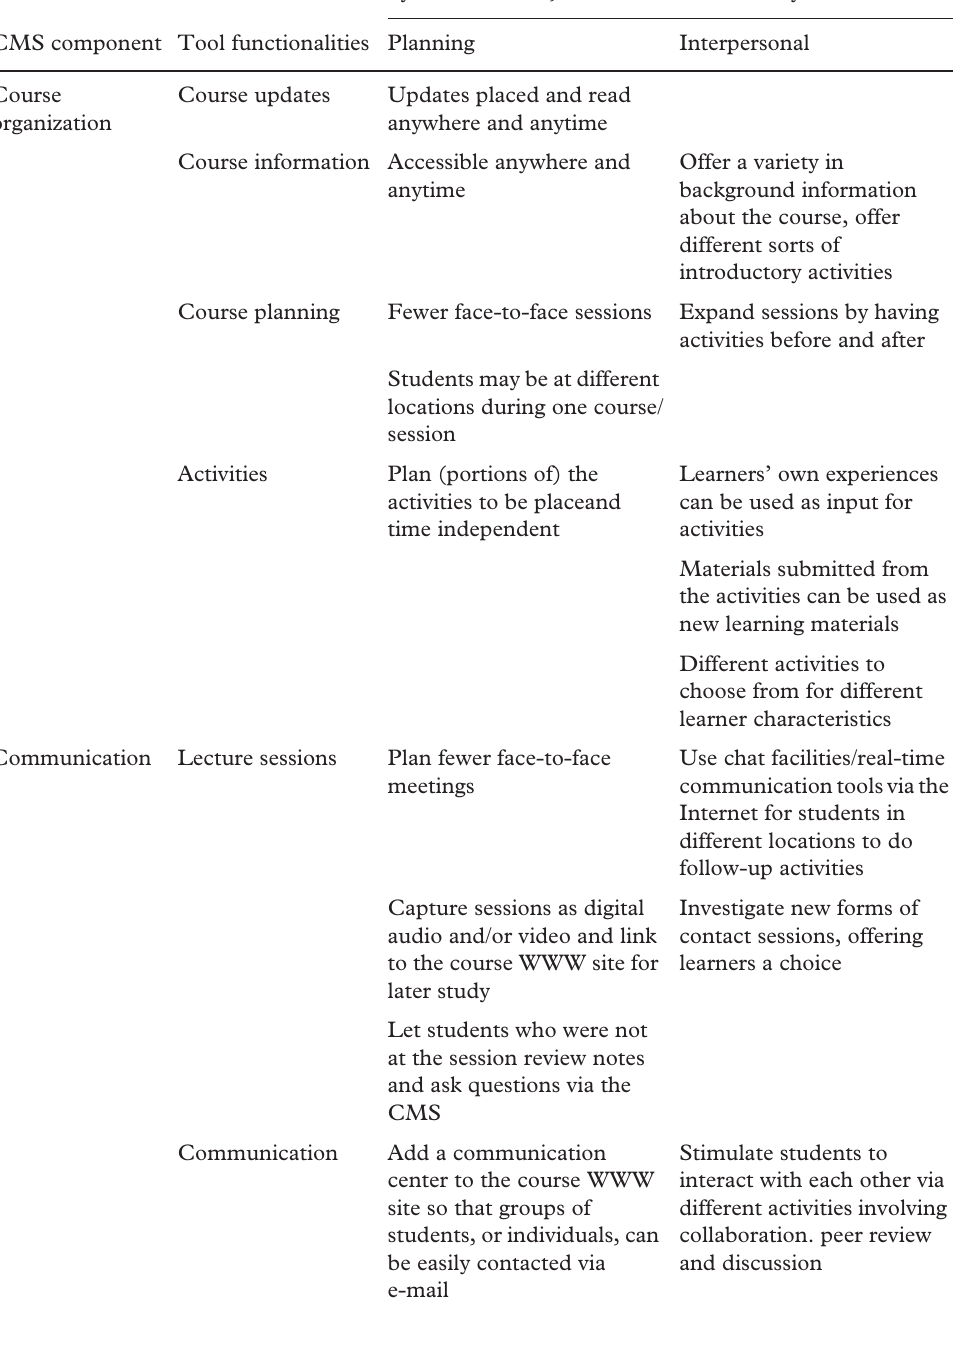
CMS component Tool functionalities